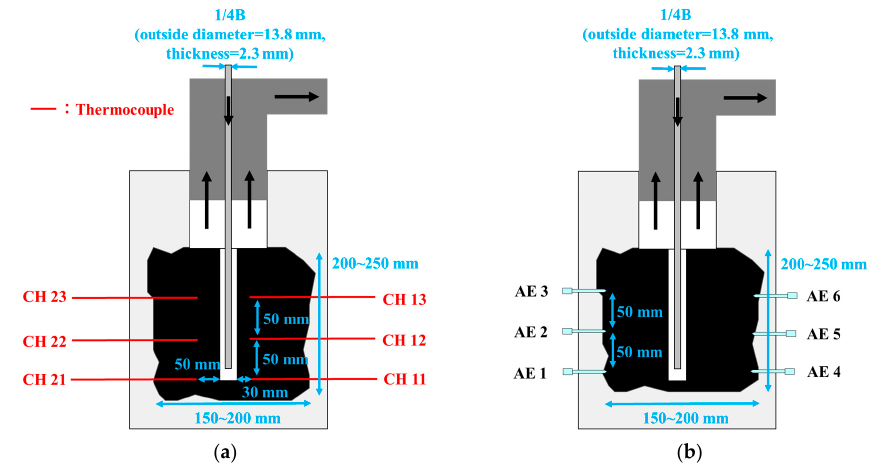
Figure 5. Layout of sensors: ( a ) Thermocouples; ( b ) Piezoelectric acceleration transducers.